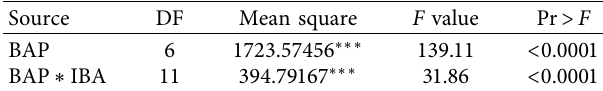
Figure 1: Seed germination and shoot induction: (a) korarima seeds cultured on 0.7% agar-solidified half-strength MS medium sterilized with 20% NaOCl solution for 20min; (b) five-weeks-old seedlings developed from seeds cultured on solid medium treated with 50% H 2 SO 4 solution for 16 hours; (c) shoot tip culture; (d) shoots initiated on MS medium containing 1.5mg/l BAP combined with 0.1 mg/l IBA after five weeks; (e) shoots initiated on liquid MS medium containing 1.5mg/l BAP combined with 0.1mg/l IBA after five weeks. Bars � 1cm. Table 1: ANOVA summary of effect of BAP and BAP ∗ IBA on in vitro shoot induction of A. corrorima